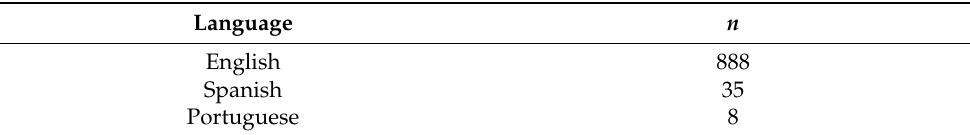
Table 2. Scientific language used.